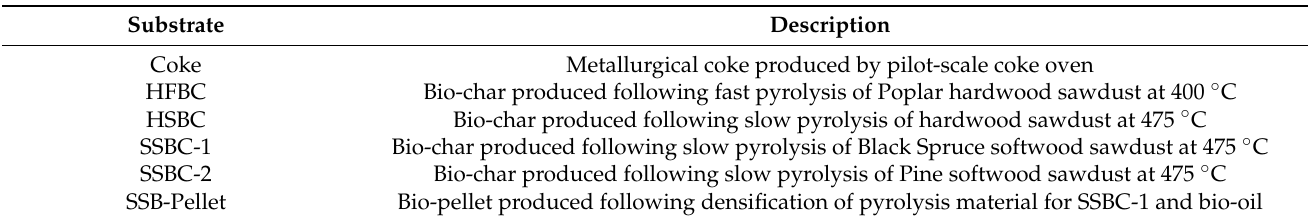
Table 4. Description of bio-char substances and coke.